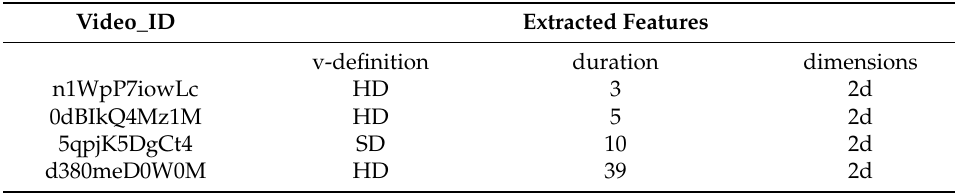
Table 4. Feature